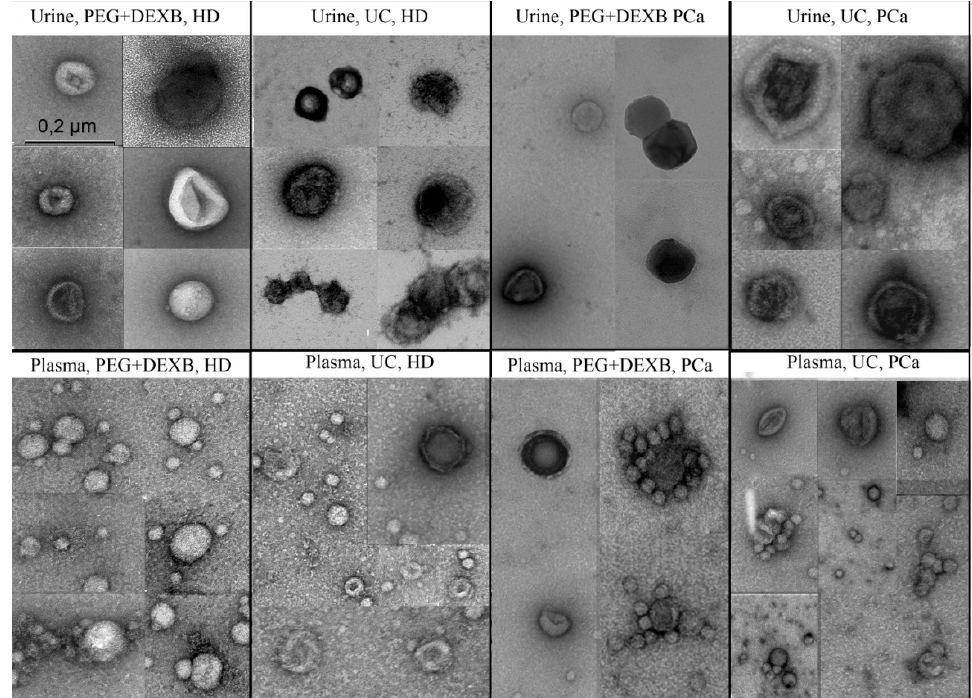
Figure 2. TEM images of plasma and urine extracellular vesicles of healthy donors and PCa patients obtained by precipitation using PEG and DEXB along with ultracentrifugation. The bar scale is provided for all presented TEM pictures. Table 2. The TEM data on EVs size in samples from healthy donors (HD). Percentage and median size is presented. The percentage of EVs (from 31 to 250 nm) was counted from total number of particles in the sample (0–250 nm). The percentage of EVs fractions (from 31 to 50 nm, from 51 to 100 nm, from 101 to 150 nm, from 151 to 200 nm, from 201 to 250 nm) were counted from number of EVs ranged from 30 to 250 nm (considered as 100%).